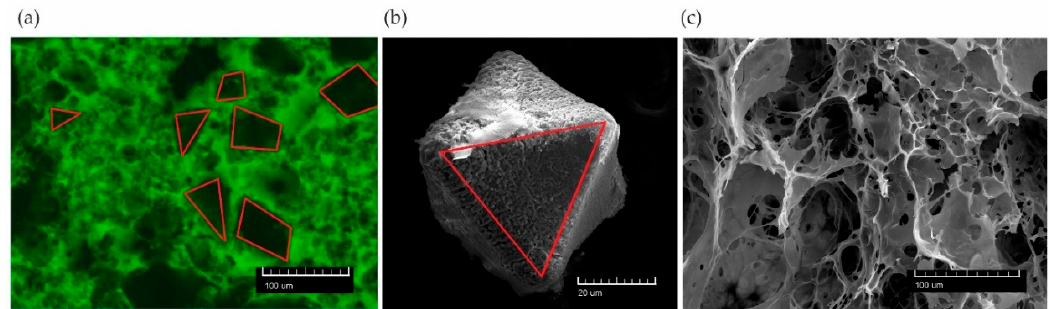
Figure 2. Comparison of the structure of sample set 3 (50–90 µm) image created by LSCM performed with unfrozen gel ( a ) and the SEM of gel previously frozen to − 195 °C ( c ) with salt crystal as porogen ( b ). Selected single pores are highlighted in red.